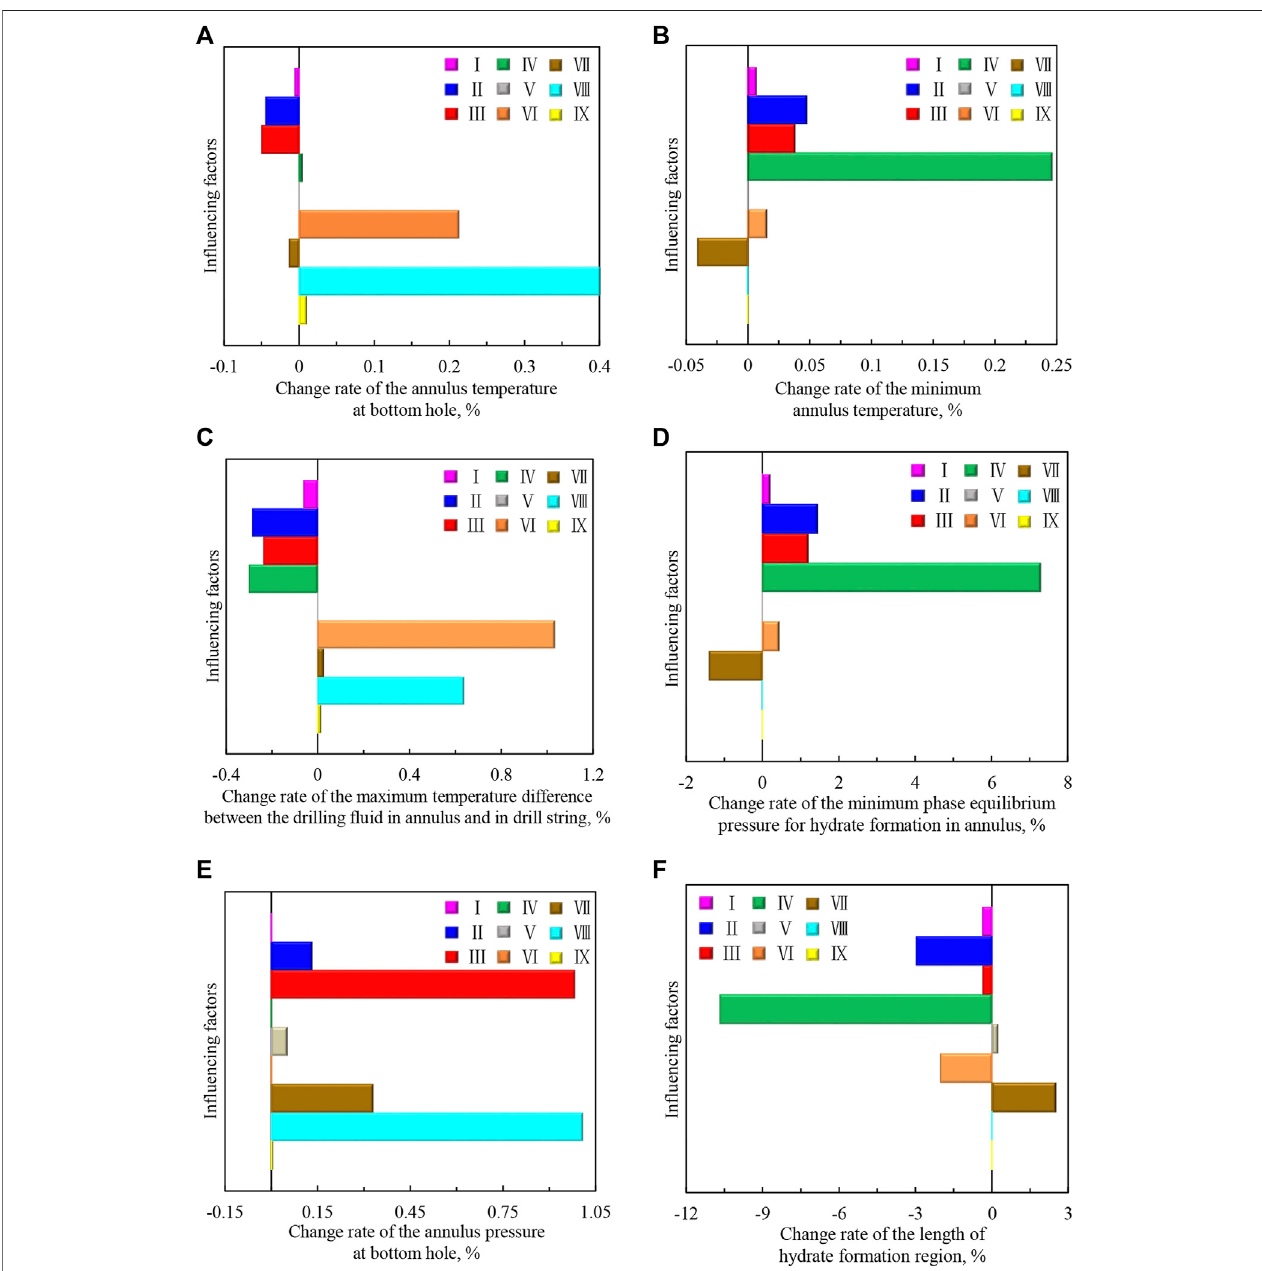
FIGURE 19 | The change rates of the calculation results when each in fl uencing factor increases by 1%: (A) the annulus temperature at the bottom hole; (B) the minimumannulustemperature; (C) themaximumtemperaturedifferencebetweenthedrilling fl uidintheannulusandinthedrillstring; (D) theminimumphaseequilibrium pressureforhydrateformationintheannulus; (E) theannuluspressureatthebottomhole; (F) thelengthofhydrateformationregion.( Ⅰ -circulationtime; Ⅱ -displacementof drilling fl uid; Ⅲ -drilling fl uid density; Ⅳ -drilling fl uid injection temperature; Ⅴ -wellhead backpressure; Ⅵ -geothermal gradient; Ⅶ -seawater depth; Ⅷ -well depth; Ⅸ -hole deviation